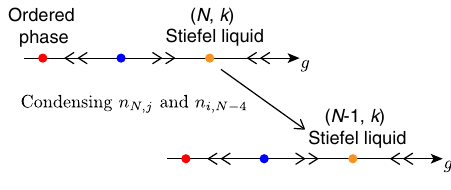
FIG. 2. The cascade structure of Stiefel